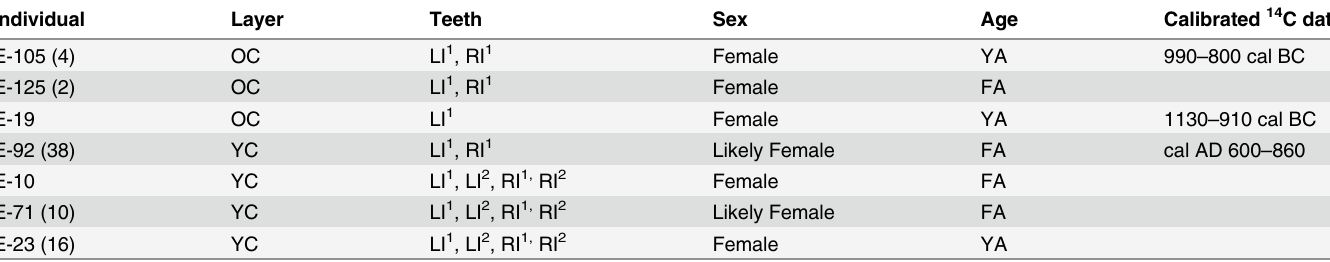
Table 1. Individuals with identified deliberate dental reduction of central and lateral